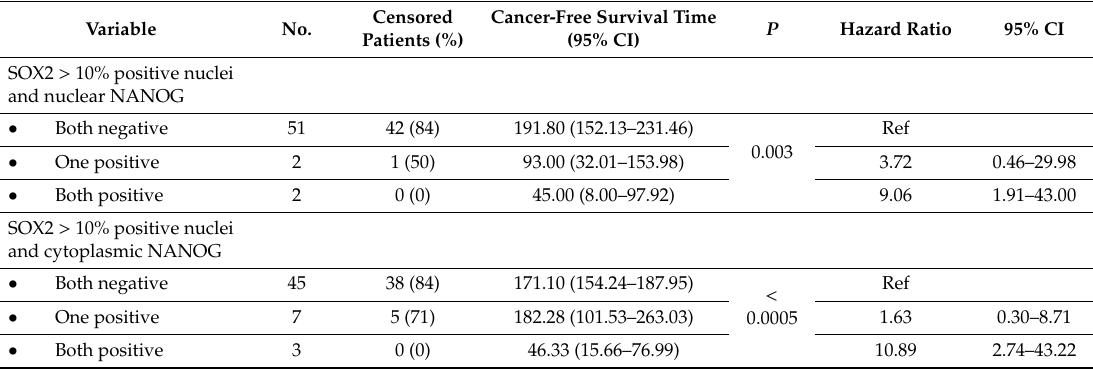
Table 5. Univariate Cox cancer-free survival analysis in 55 patients with oral dysplasia categorized by both SOX2 and NANOG